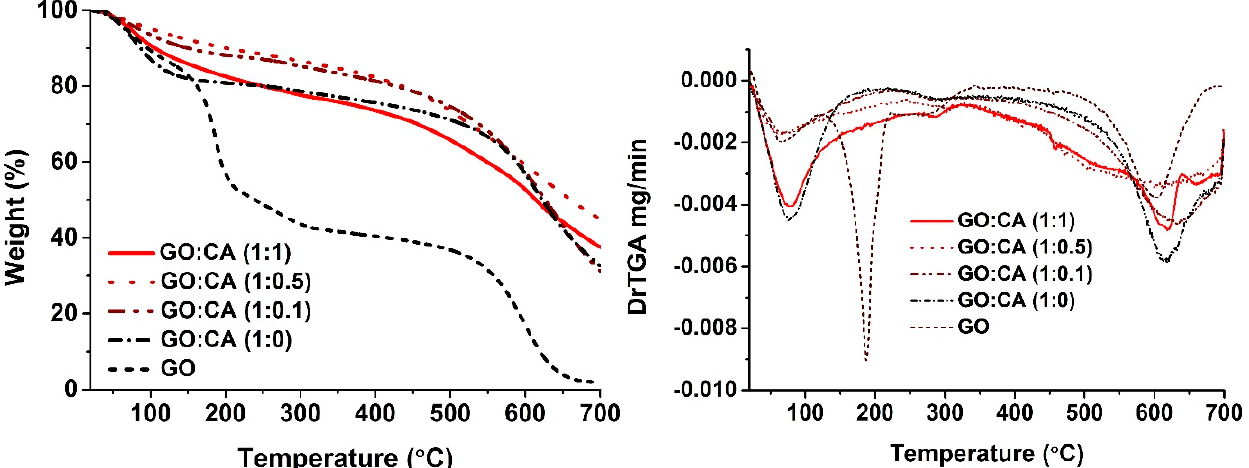
Figure 8. TGA and DTG curves of GO and rGO samples obtained under air atmosphere.